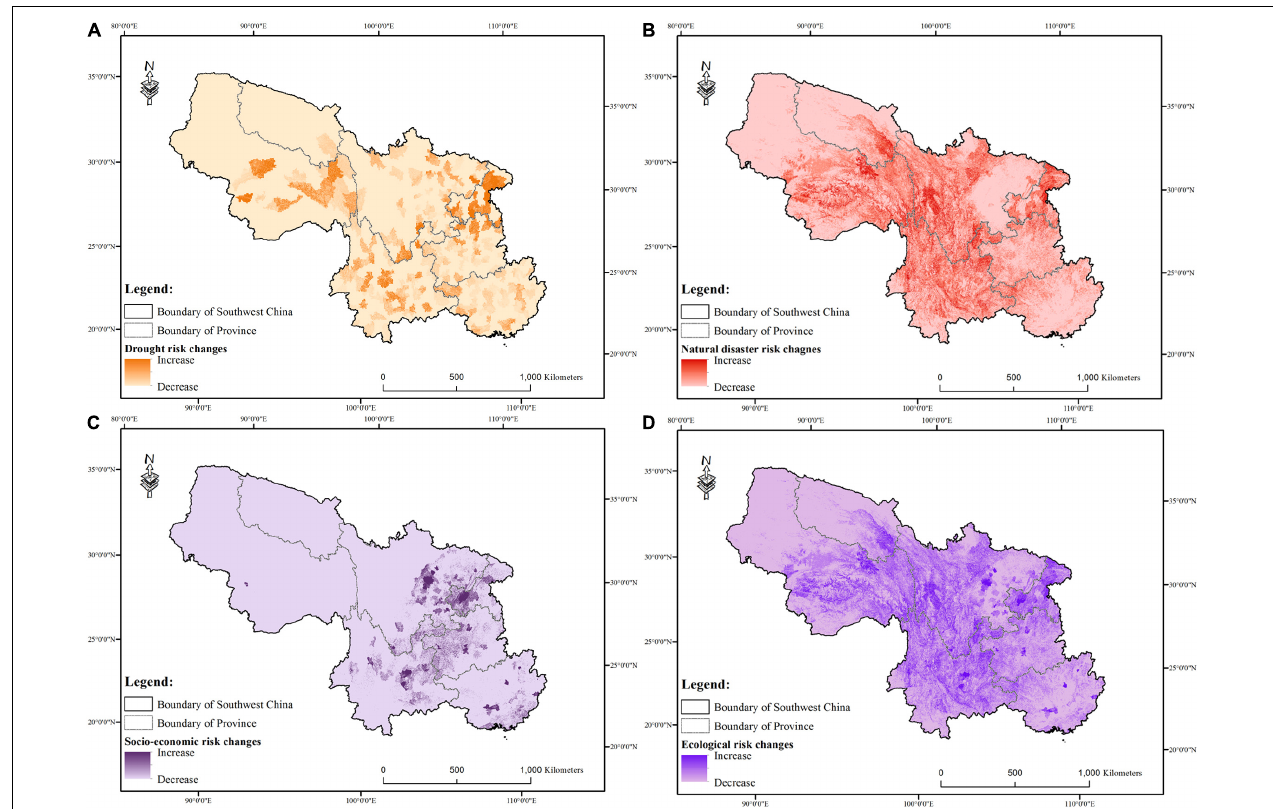
FIGURE 4 | Drought risk (A) , natural disaster risk (B) , socio-economic risk (C) , and ecological risk changes (D) from 1900 to